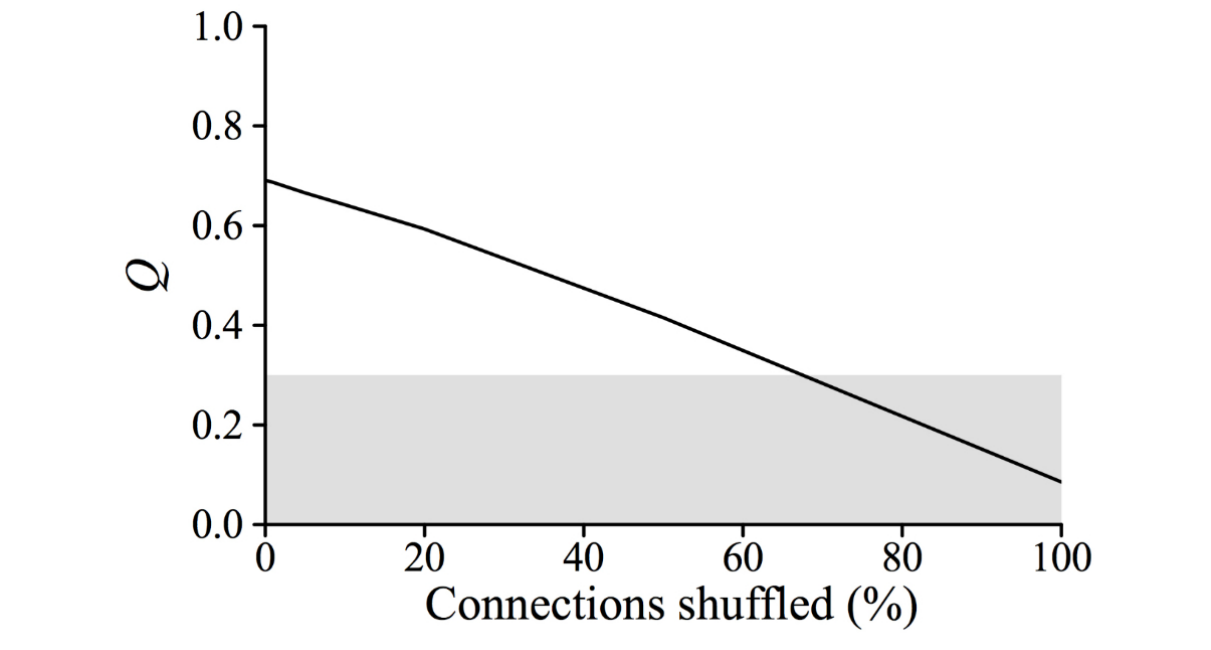
Figure 7. Relationship between modularity (Q) and network shuffling. Shaded area indicates the conventional community structure threshold of 0.3. Note larger x-axis range in this figure compared with other